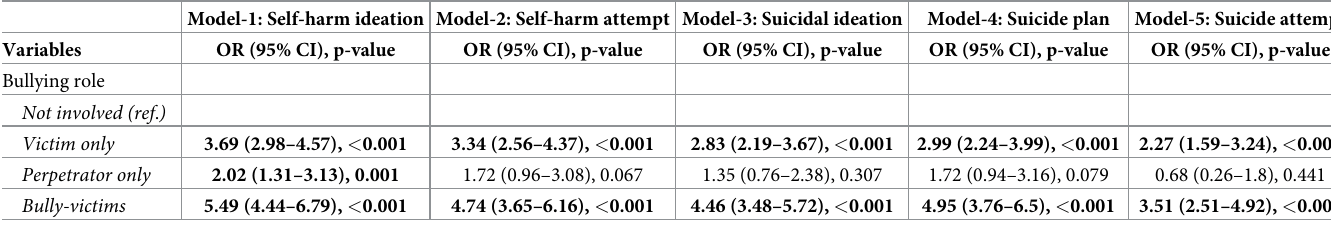
Table 2. Base models predicting self-harm and suicide-related behaviors. Model-1: Self-harm ideation Model-2: Self-harm attempt Model-3: Suicidal ideation Model-4: Suicide plan Model-5: Suicide attempt